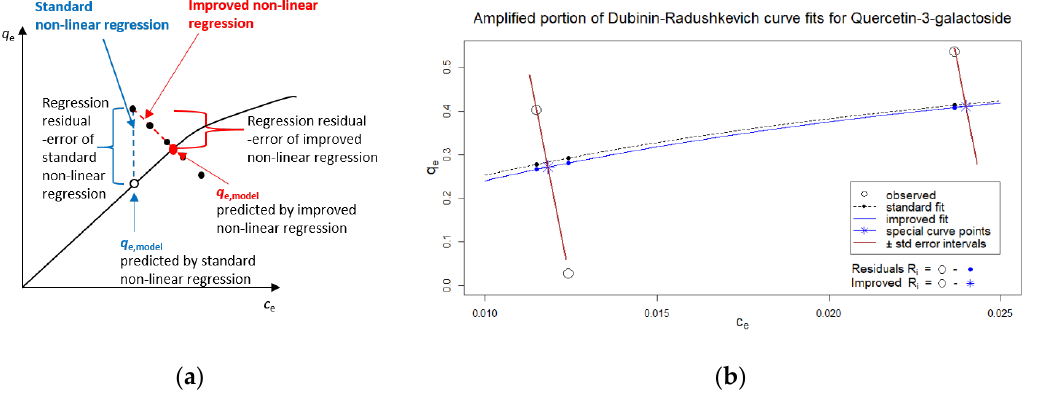
Figure 2. ( a ) Theory of non-linear regression of adsorption data with standard non-linear regression and novel improved non-linear regression. ( b ) amplified figure of example of novel improved non-linear regression of Dubinin-Radushkevich isotherms (quercetin-3-galactoside adsorption onto β-glucan).